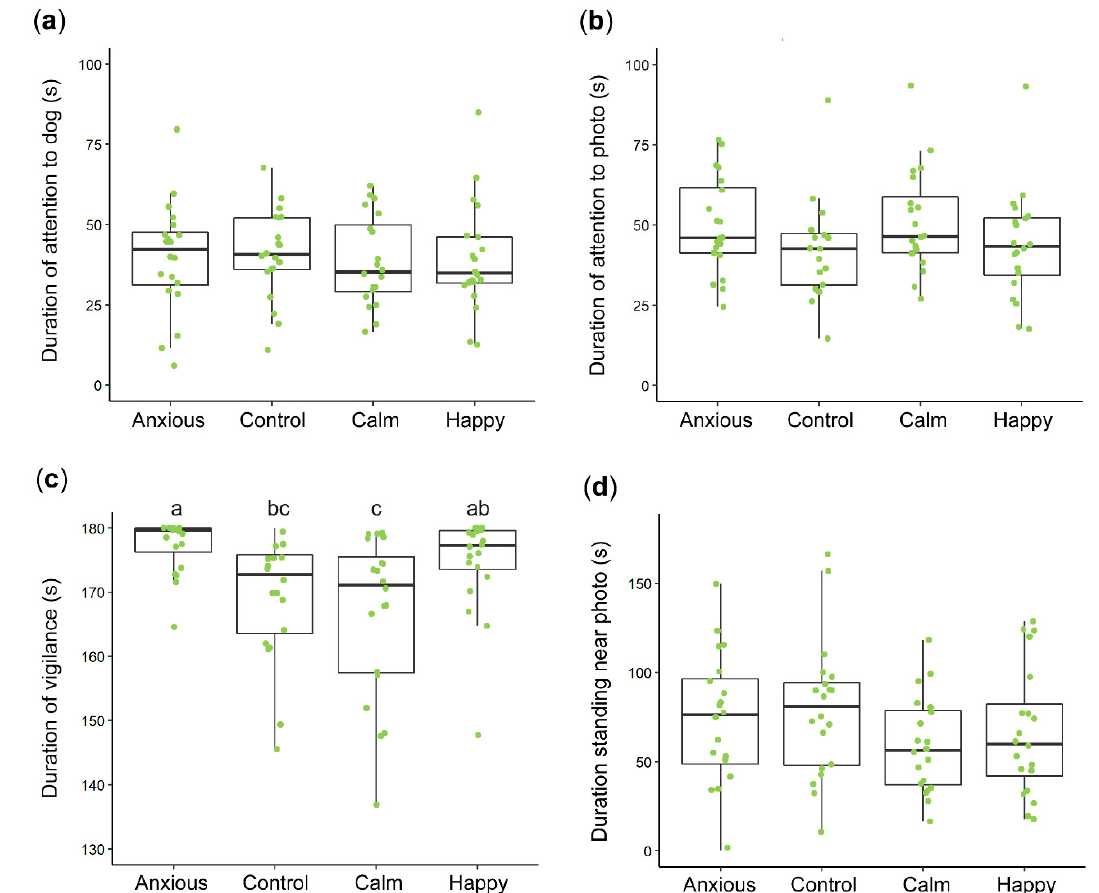
Figure 2. Boxplots summarizing the raw data within each treatment group for looking behaviors ( a , b ), vigilance ( c ) and duration spent standing near the photo ( d ). Boxplots display the median durations, the interquartile range (IQR) and the range of data within 1.5 × the IQR. The raw duration data for individuals within each treatment group are represented by the dots. Data were analyzed using linear mixed effects models. Significant differences between groups ( a , b , c ) were only found for vigilance data. Note that the plot axes are scaled differently.